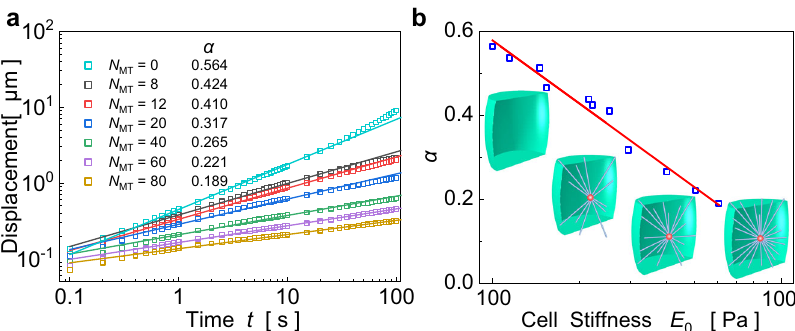
Fig. 2 Simulated power-law rheology of cells with adjustable power-law exponents as the number of emanative MTs is varied. a Displacement responses of cells with different numbers of emanative MTs (from 0 to 80). b The power-law exponent decreases linearly with the increase of cellular stiffness E 0 in a semi-logarithmic